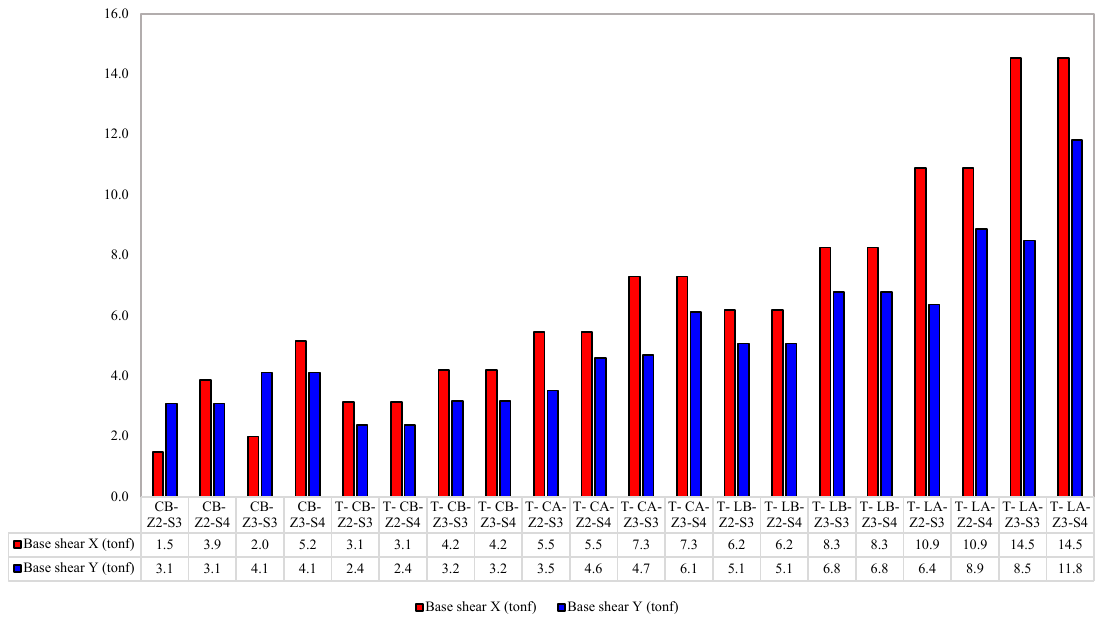
Figure 5. Base shear by direction.